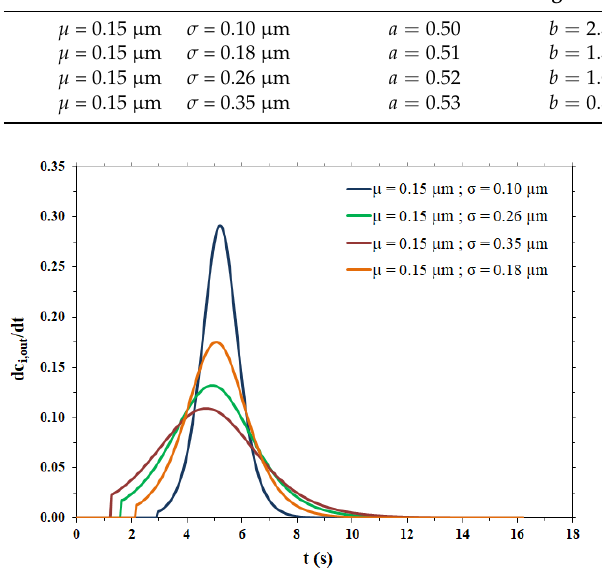
Figure 5. Pulse response peaks for the different pore size distributions.